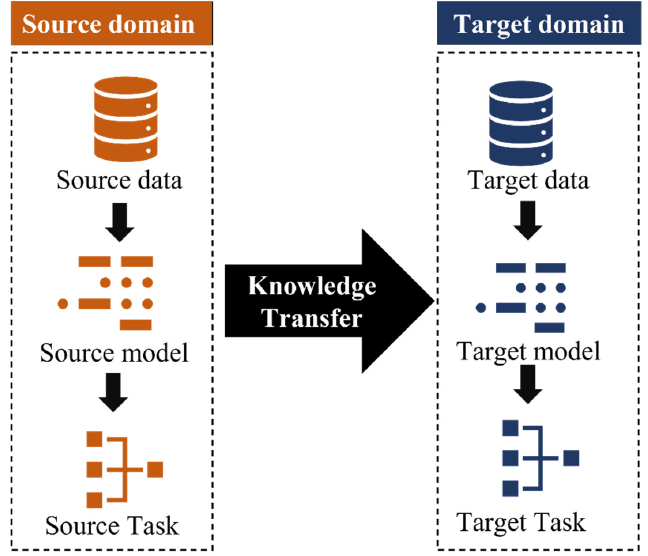
Figure 6. Framework of the TL between the source and target domain.